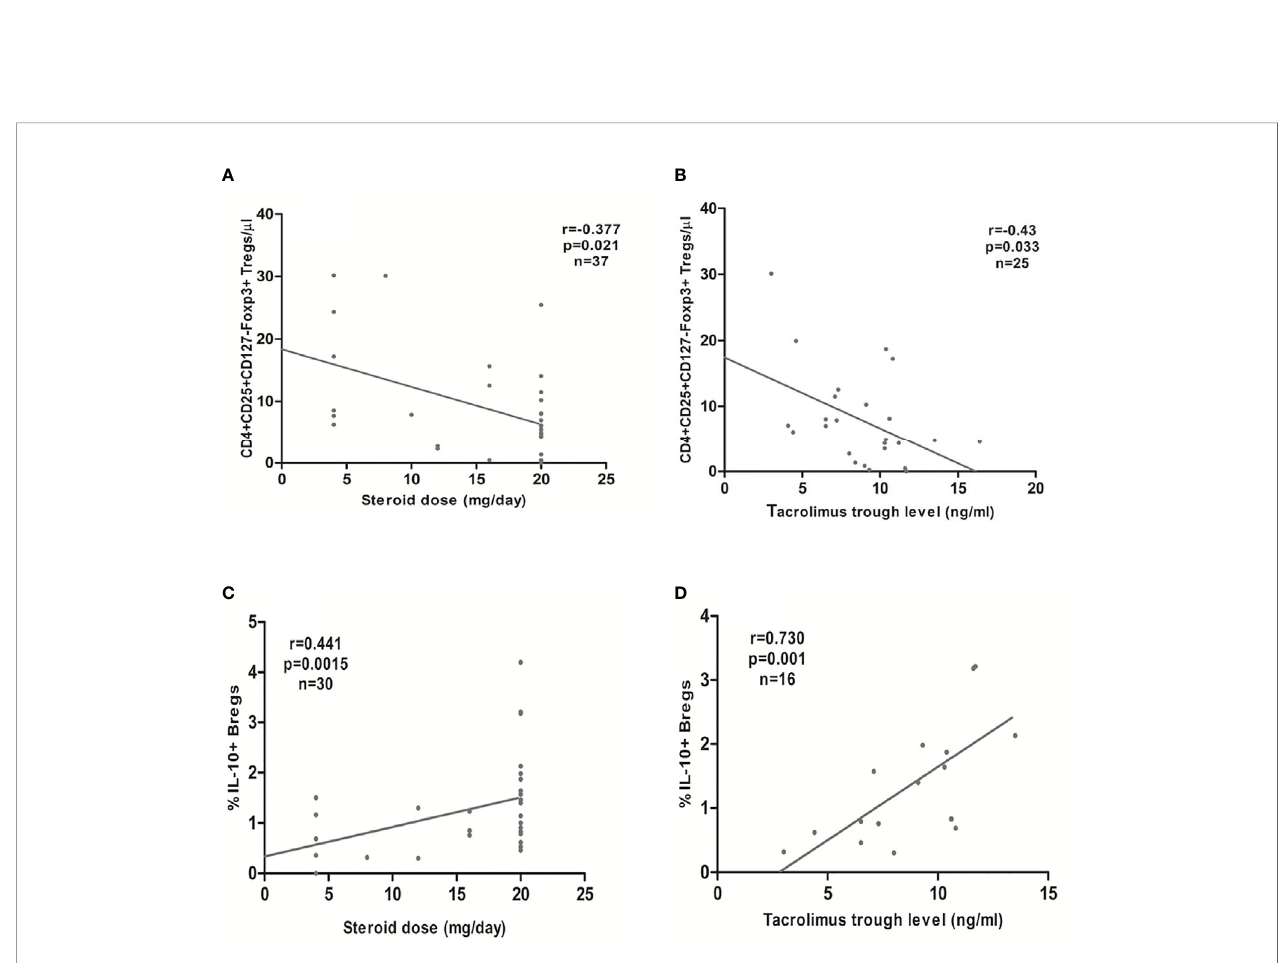
FIGURE 7 | Association between the steroid daily dose or tacrolimus trough levels in early transplant recipients and the absolute CD4+CD25+CD127-Foxp3+ Tregs ( A , B , respectively) or the relative CD19+IL-10+ Breg count (percentage of CD19+IL-10+ to the total CD45+ lymphocyte pool) ( C , D , respectively): CD4+CD25 +CD127-Foxp3+ Tregs showed a signi fi cant inverse association with steroid daily dose and tacrolimus trough levels, whereas CD19+IL-10+ Bregs showed a signi fi cant positive association with steroid daily dose and tacrolimus trough